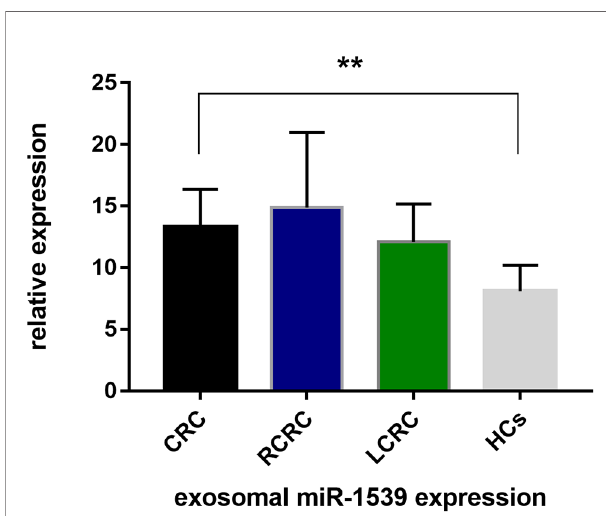
FIGURE 2 | Exosome-based miR-1539 expression levels between CRC, LCRC, RCRC and HCs groups. Exosomal miR-1539 was upregulation in CRC ( p = 0.003). Y-axis represents miR-1539 relative expression by 2 - △ Ct method. Mean with 95%CI are performed in the bars. CRC, colorectal cancer; HCs, healthy controls. RCRC, right-sided CRC; LCRC, left-sided CRC. *p<0.05, **p<0.01